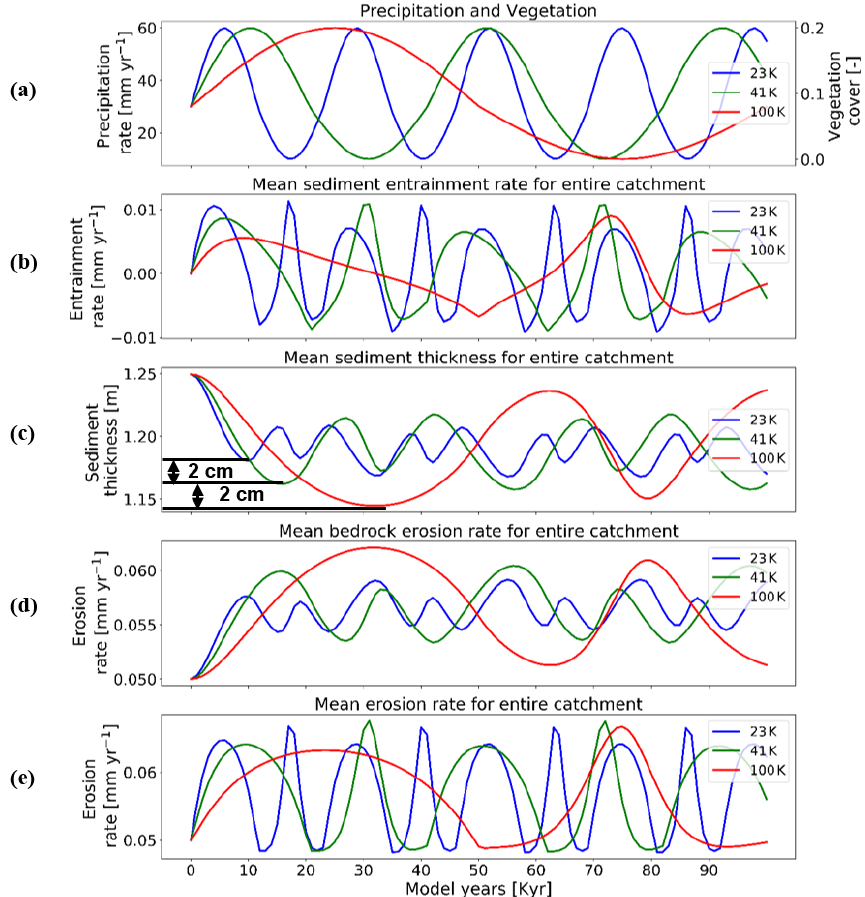
Figure 8. Temporal evolution of catchment-averaged predictions for scenario 4 described in the text (Sect. 3.4). Graphical representation of mean catchment sedimentation and erosion to (a) different periodicities of coupled oscillations in precipitation [mmyr − 1 ] and vegetation cover [–] in terms of (b) sediment entrainment [mmyr − 1 ], (c) sediment thickness [m], (d) bedrock erosion [mmyr − 1 ], and (e) mean erosion rates [mmyr − 1 ] for the entire catchment. The rate of rock uplift is kept constant at 0.5mmyr − 1 . The simulations represent 10% initial vegetation